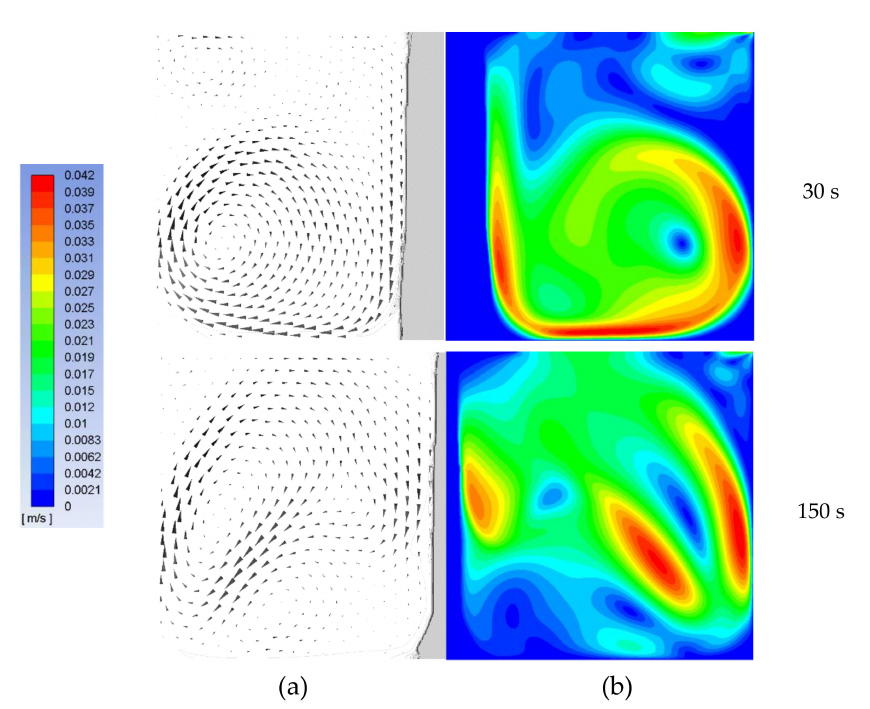
Figure 13. The flow fields ( a ) and contours ( b ) of the bath at di ff erent melting time for 1350 ◦ C.